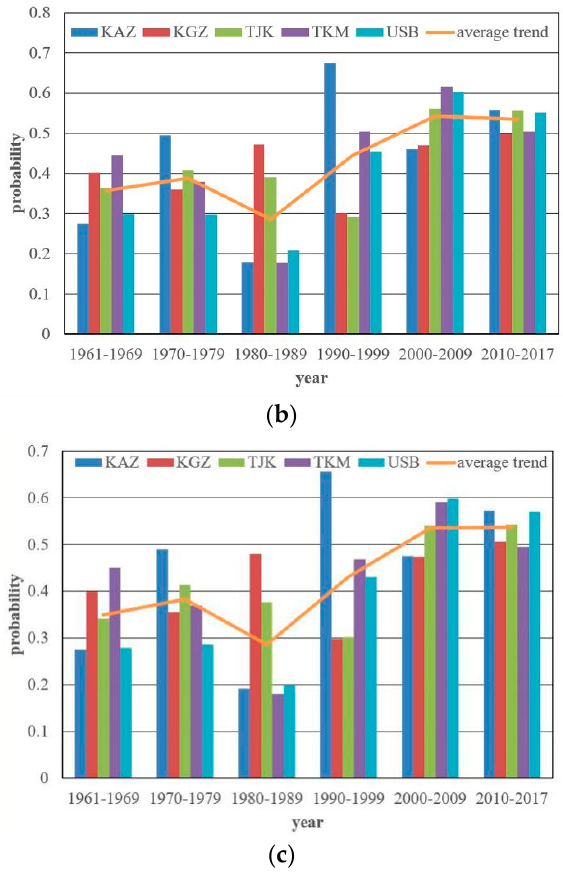
Figure 8. The 2D drought risk (joint probability) of five countries in CA: ( a ) Ds-Dd; ( b ) Ds-Dp; ( c ) Dd-Dp.